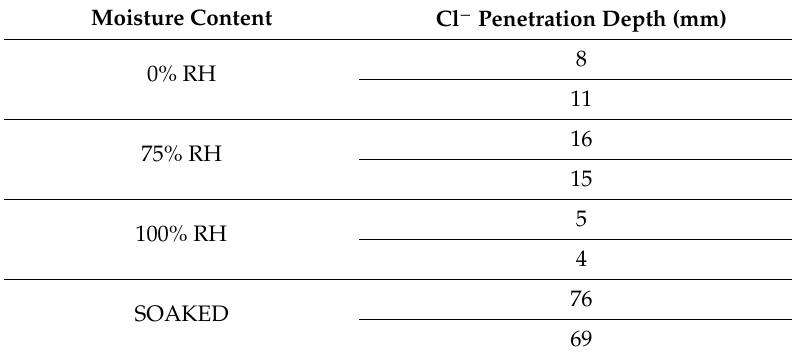
Table 3. Average penetration depth for composite samples.